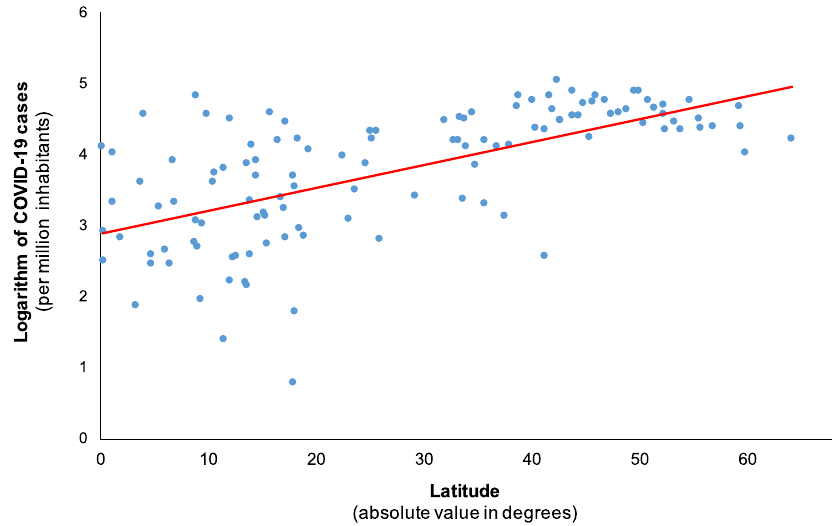
Figure 1. Scatterplot of the natural logarithm of COVID-19 cases per million inhabitants against absolute latitude in degrees for the full sample of countries (R 2 =